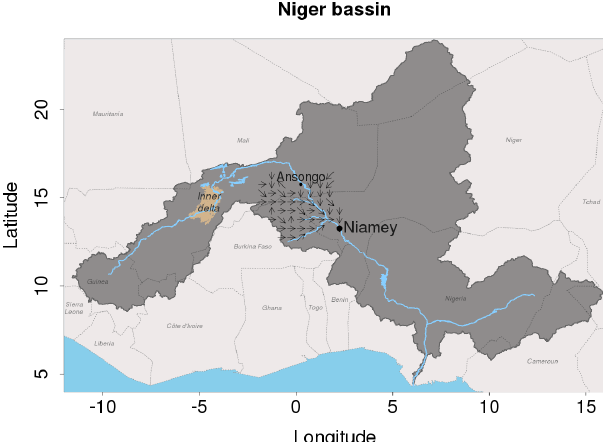
Figure 1. The Niger River basin, modified from Casse et al. (2015). The black arrows represent the stream flow direction in TRIP, for the 49 pixels of the hydrological modelling domain between Ansongo and